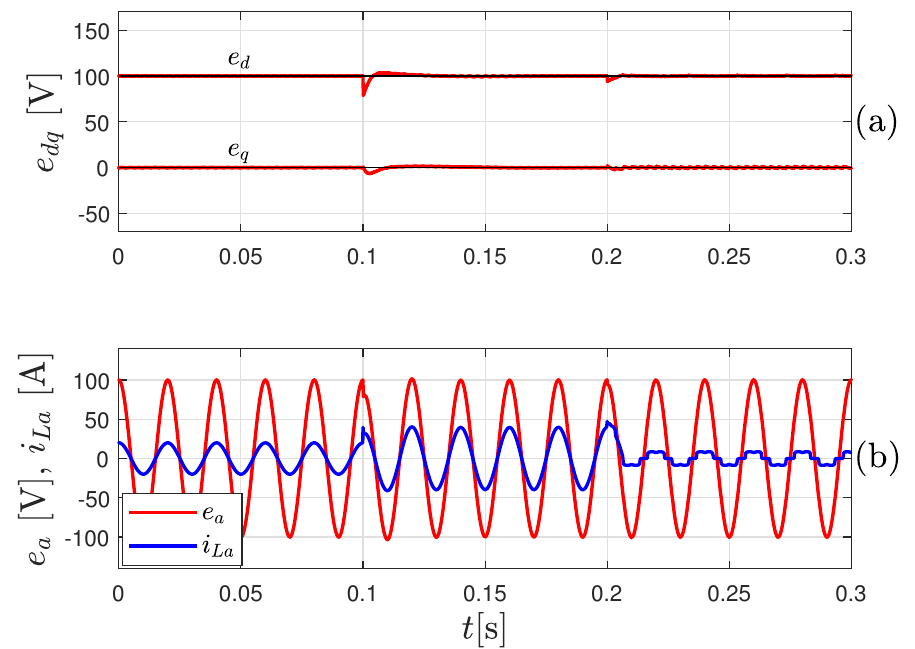
Figure 4. Voltage behavior in the Park’s reference frame, and voltage and load current per-phase. ( a ) e dq profile. ( b ) Voltage and load current in phase a .